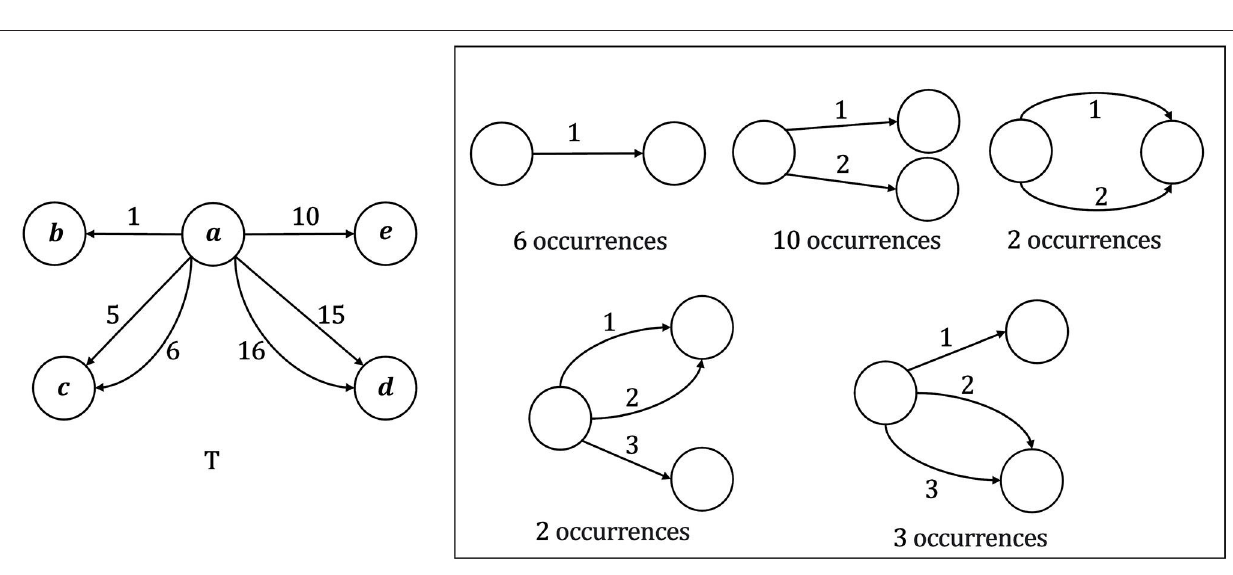
edge e , respectively. A temporal graph G